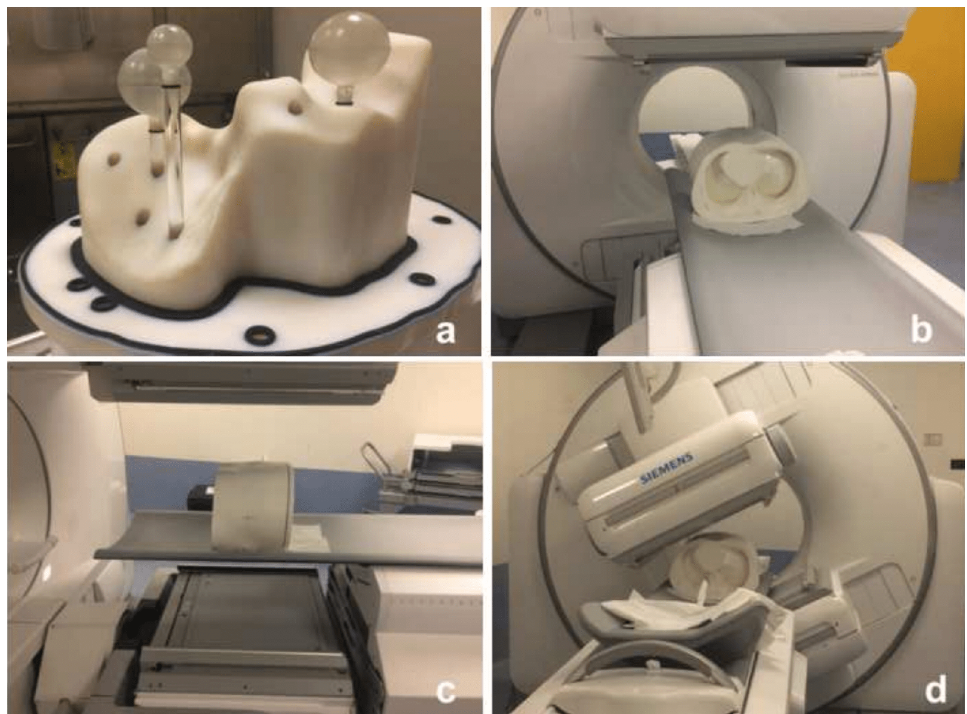
Figure 1. AbdoMan 3D printed phantom used in this study. ( a ) the phantom is provided with a fillable liver compartment containing three spherical inserts: two spherical and homogeneous inserts of 20 mm and 40 mm in diameter and a 40 mm in diameter hollow sphere with 25 mm in diameter fillable inner sphere to simulate a necrotic lesion. ( b , c ) phantom positioning in the SPECT/CT system and ( d ) SPECT/CT image acquisition of the